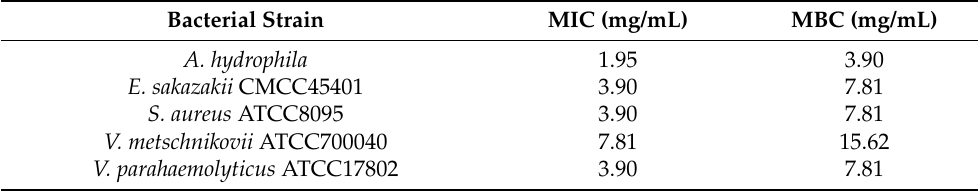
Table 2. The MIC and MBC values of the GMPE against the five species of bacteria. Bacterial Strain MIC (mg/mL) MBC